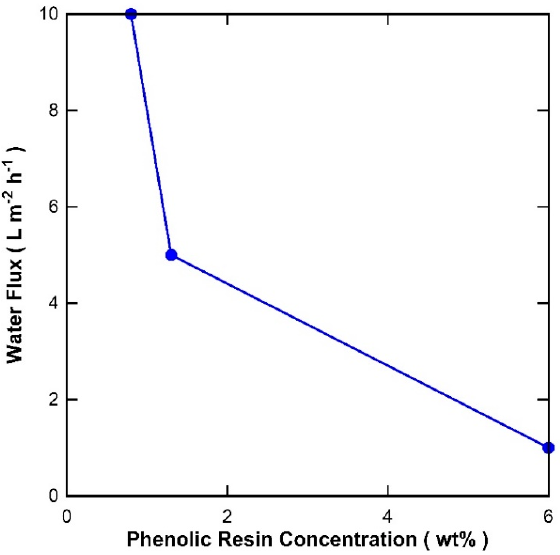
Figure 5. Pure water flux (±8%) of membranes impregnated with phenolic resin of 1 wt % in the first-step and varying phenolic resin concentration in the second step.